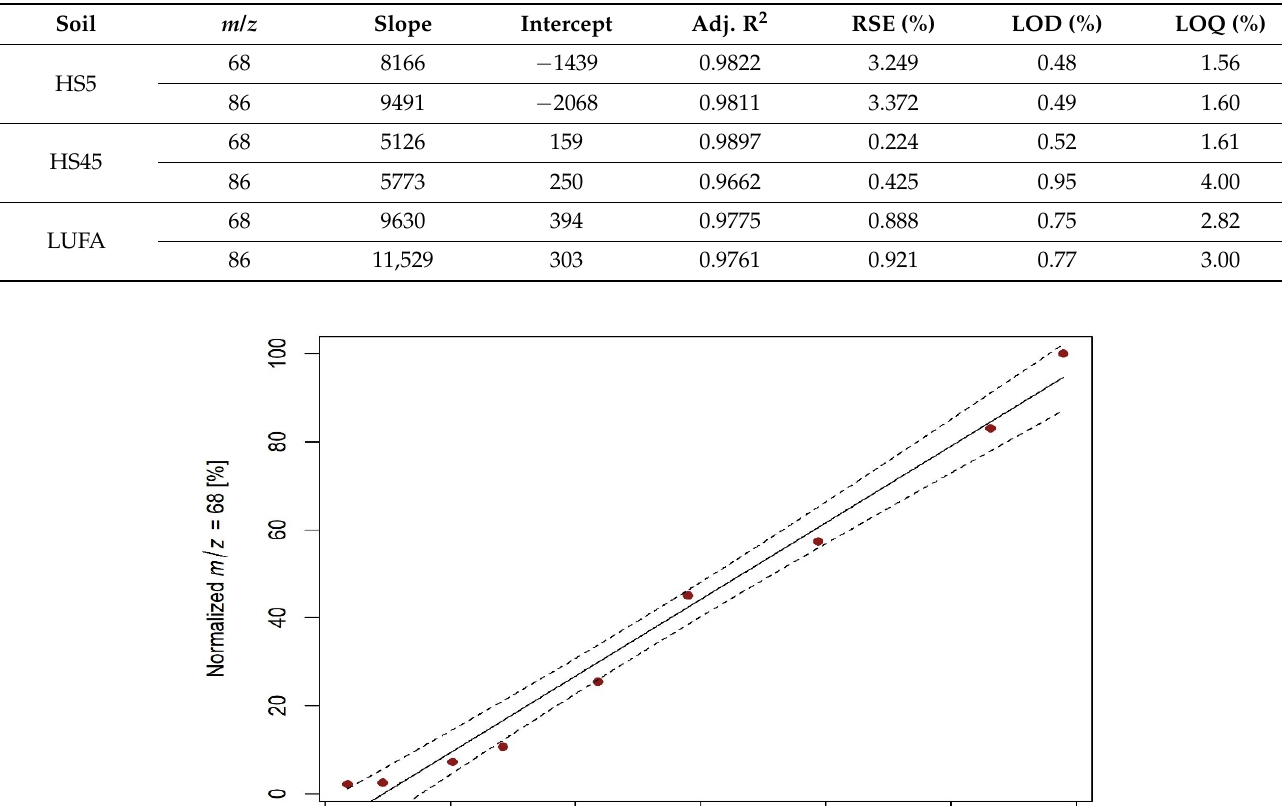
Table 2. Parameters of calibration lines for the determination of PHB micro-bioplastics in standard LUFA soil and two real soils by detection of degradation gas products with m / z 68 and 86.